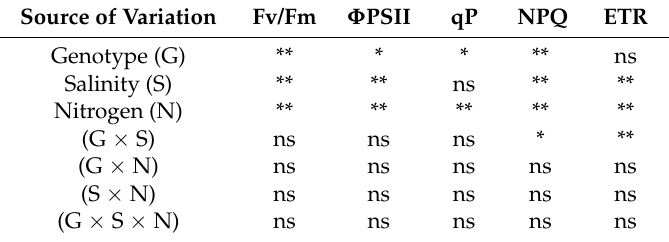
Table 5. Summary of analysis of variance for maximum quantum efficiency of PSII (Fv/Fm), actual photochemical quantum efficiency of PSII ( Φ PSII), photochemical quenching (qP), non-photochemical quenching (NPQ) and electron transfer rate (ETR) at the flowering stage in the first run of a controlled greenhouse study.